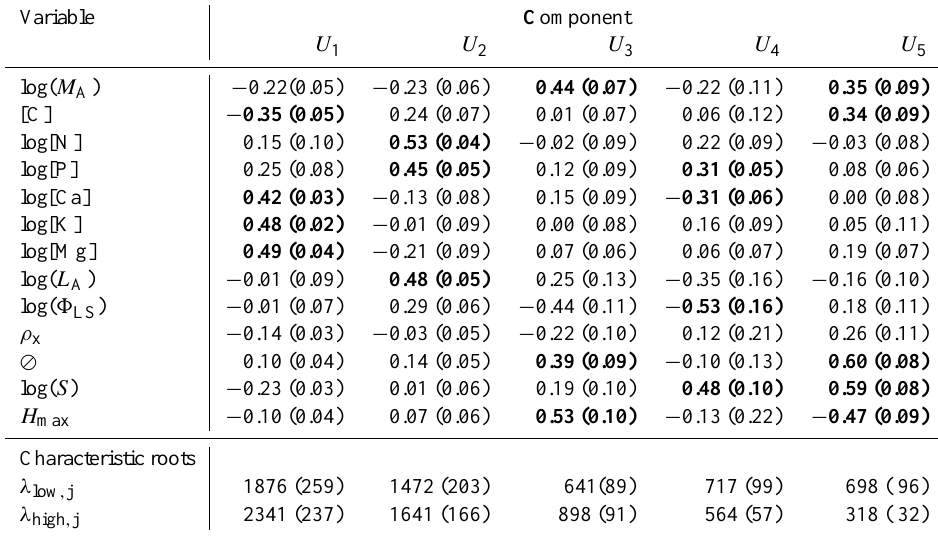
Table 2. Common principal component analysis of derived genetic effects for species associated with low and high fertility soils. Values in brackets represent standard errors for each component. Coefficients given in bold are either those whose absolute values are 0.50 or more, or 0.30 or more with a standard error of less than 0.1. M A = leaf mass per unit area; elemental concentrations are on a dry weight basis, L A = leaf area; 8 LS = leaf area:sapwood area ratio, ρ x = branch xylem density, (cid:11) = diffusion limitation index (see Eq. 1), S = seed mass, H max = species maximum height.